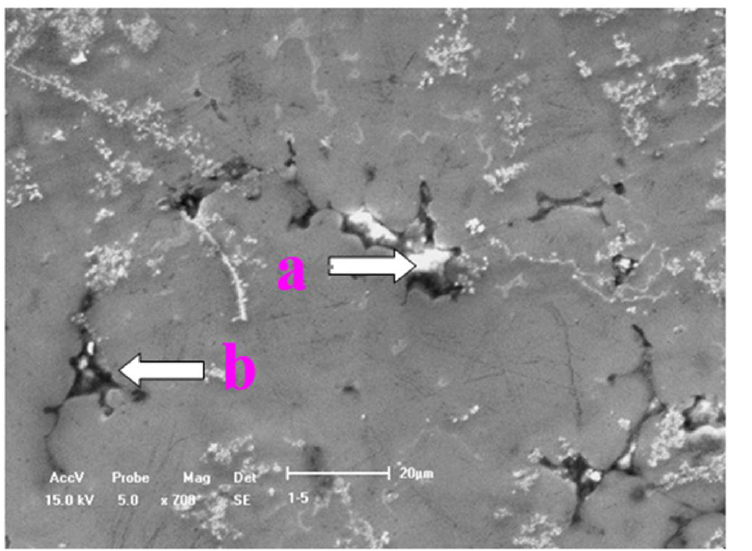
Figure 4. SEM image of AZ80 alloy in A-zone. a and b are inclusions in different regions respec- tively.